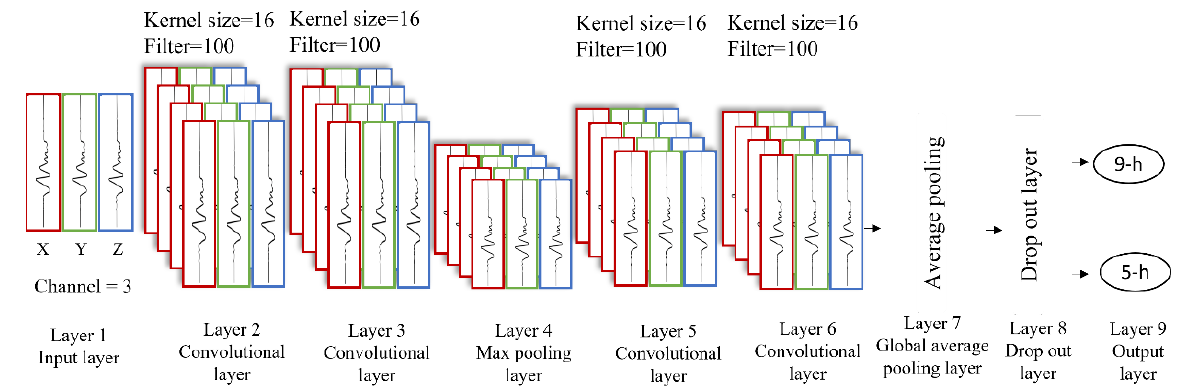
Figure 2. DixonNet convolutional neural network architecture. The final fully connected layer acts as the output layer for binary classification (i.e., sitting or breaking up sitting or 9-h or 5-h sleep history).